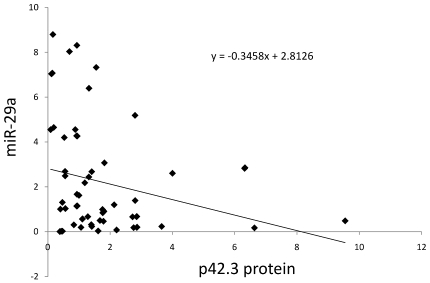
The scatterplot of the expression of p42.3 protein and miR-29a in 60 gastric cancer tissues.There was an inverse relationship between the expression of p42.3 protein and miR-29a and the equation of their relationship was y = −0.3458x+2.8126 (y: the expression of miR-29a, x: the expression of p42.3 protein).